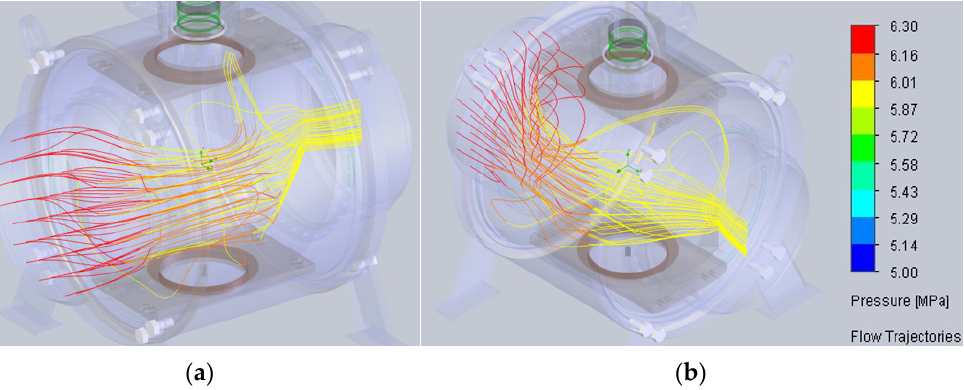
Figure 6. Pressure line trajectories for a 45° closure angle: ( a ) upstream view; ( b ) downstream view.